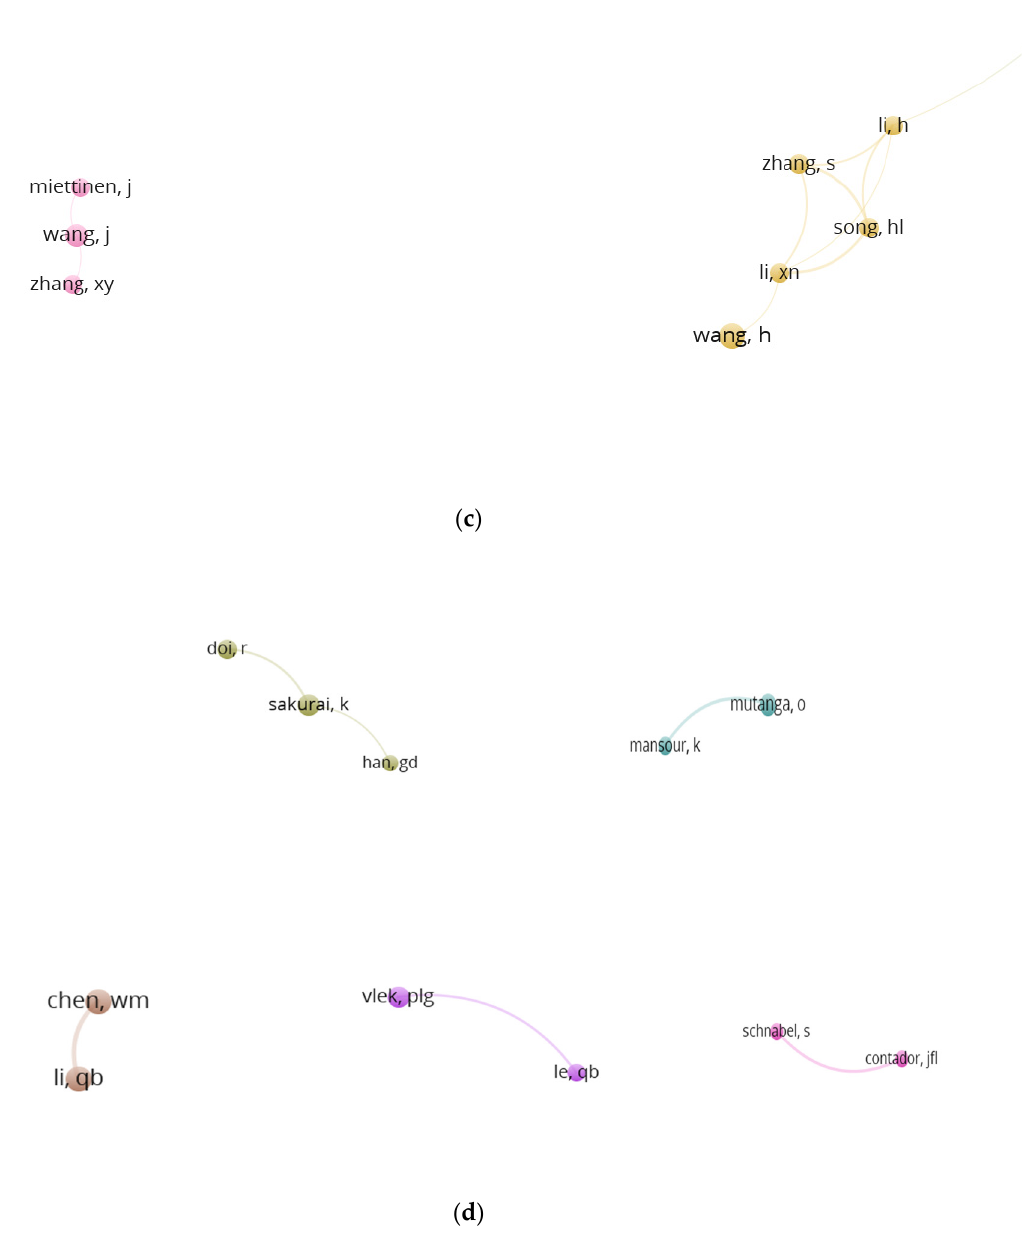
Figure A1. Sub-networks of collaboration map of authors in the field of land degradation.